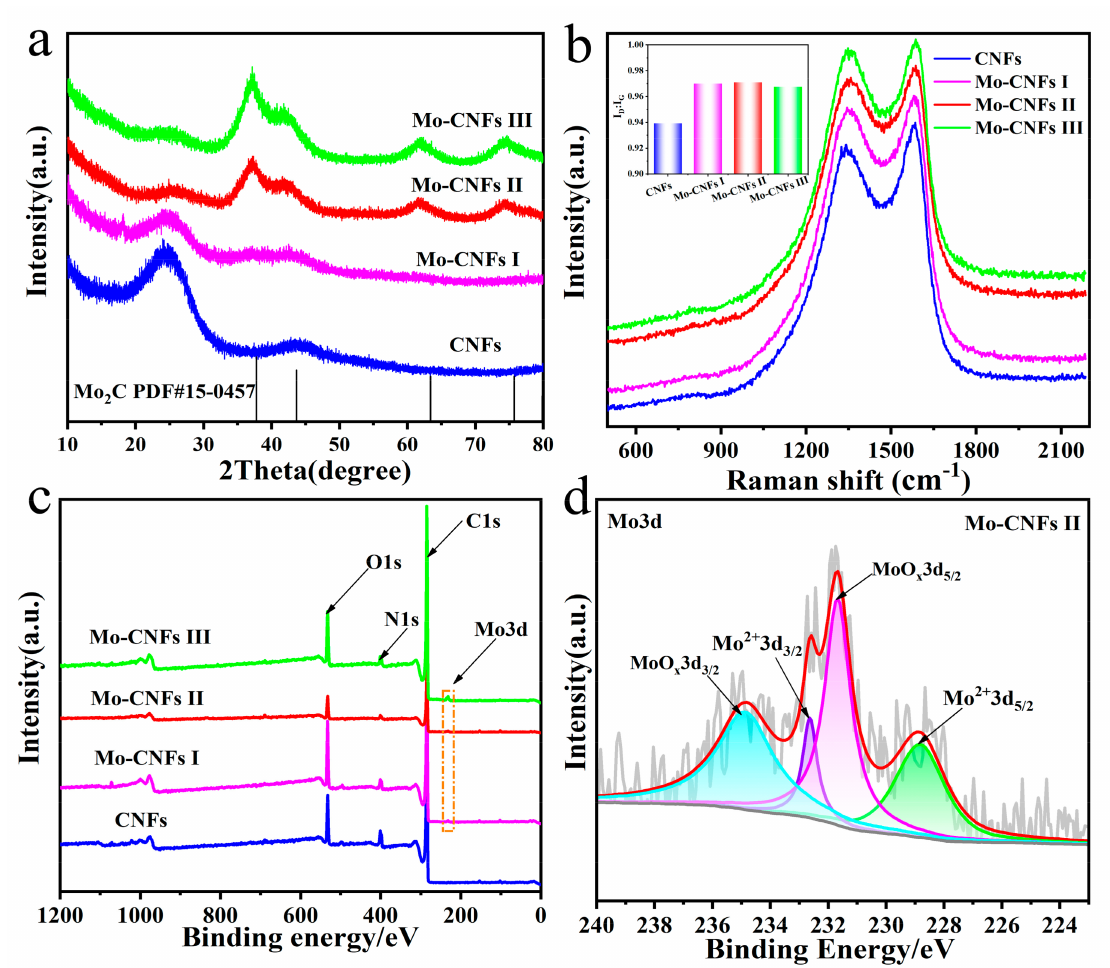
Figure 2. ( a ) XRD patterns of various Mo-CNFs and CNFs; ( b ) Raman image (insert is a histogram of I D :I G values); ( c ) total XPS spectra of CNFs and different Mo-CNF composites; ( d ) high-resolution Mo 3d XPS spectrum of Mo-CNF